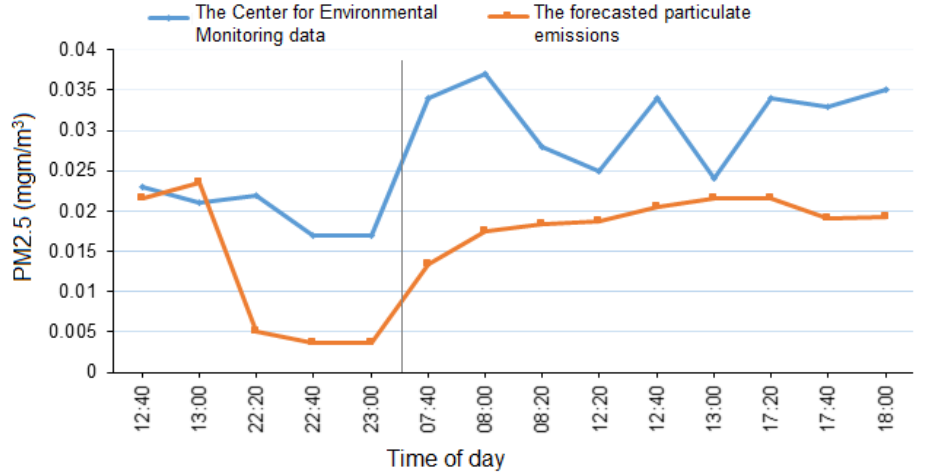
Figure 15. Comparison of the forecasted and actual PM2.5 emission concentrations.